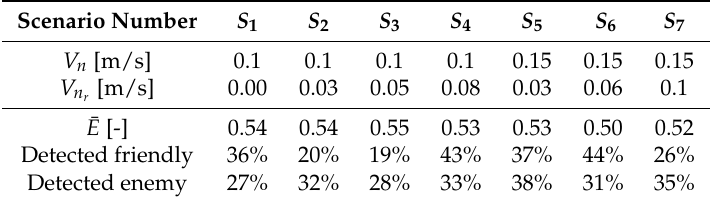
Table 5. Overview of the case study results, considering 7 different scenarios (from S 1 to S 2 ). V n is the nominal speed of the quadcopter; V n , the speed of the ground robots; ¯ E the mean efficiency for each r scenario over 5 tests; Detected friendly , the percentage of friendly intruders that have been detected; Detected enemy , the percentage of enemies